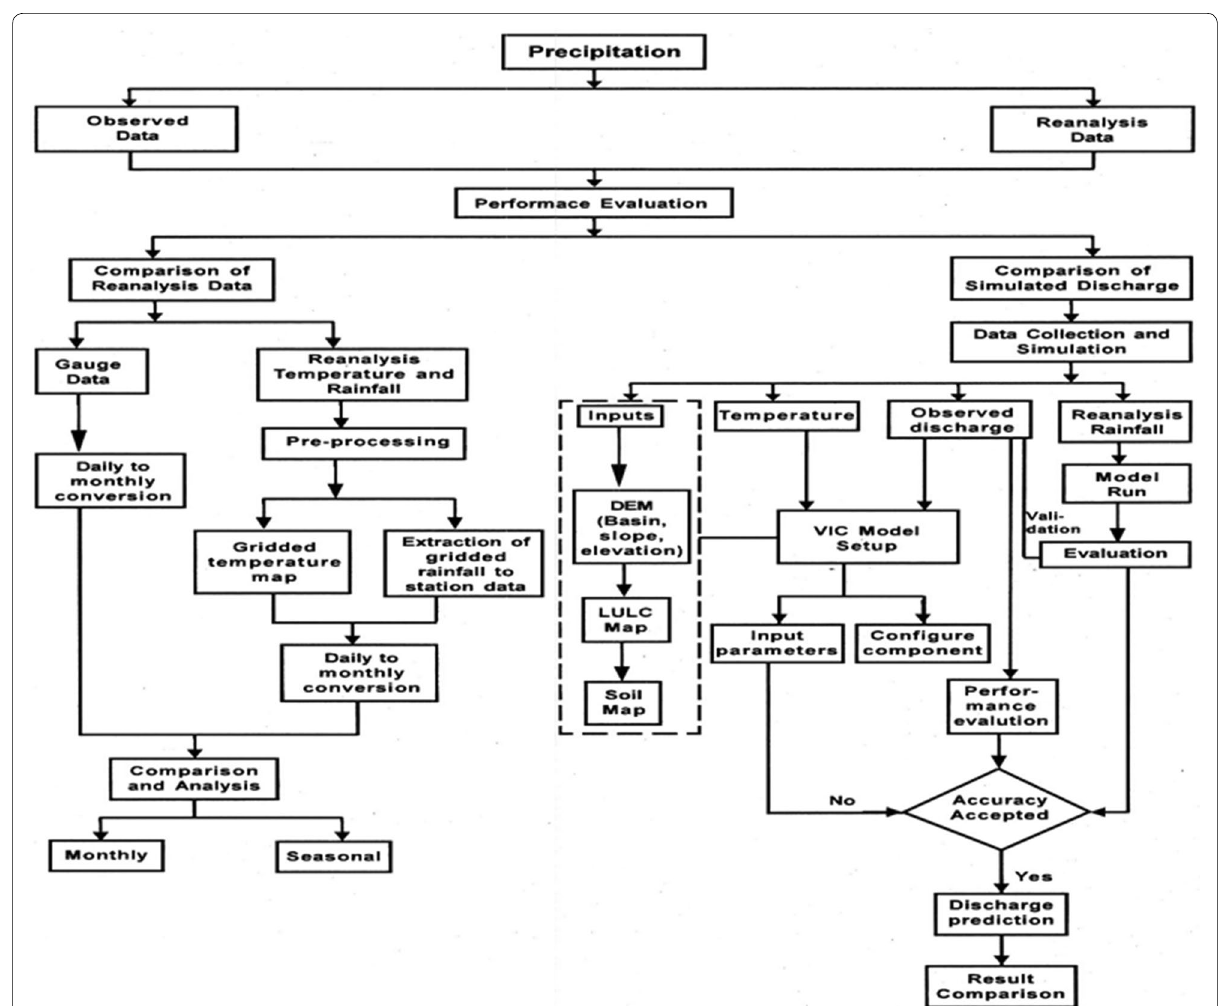
Fig.6 Flowchart of methodology used in this